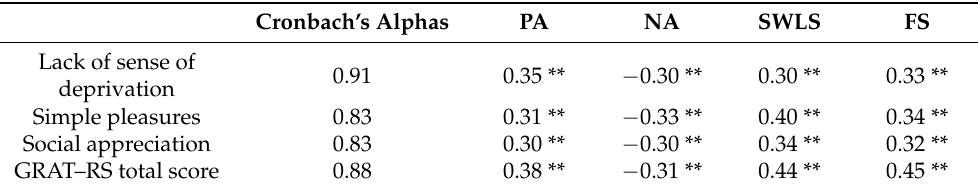
Table 2. Correlations of the Italian version of GRAT–RS with PANAS, SWLS and FS; Cronbach’s Alphas for the three dimensions and the total score of the Italian version of GRAT–RS. Cronbach’s Alphas PA NA SWLS FS Lack of sense of 0.91 0.35 ** − 0.30 ** 0.30 ** 0.33 ** deprivation Simple pleasures 0.83 0.31 ** − 0.33 ** 0.40 ** 0.34 ** Social appreciation 0.83 0.30 ** − 0.30 ** 0.34 ** 0.32